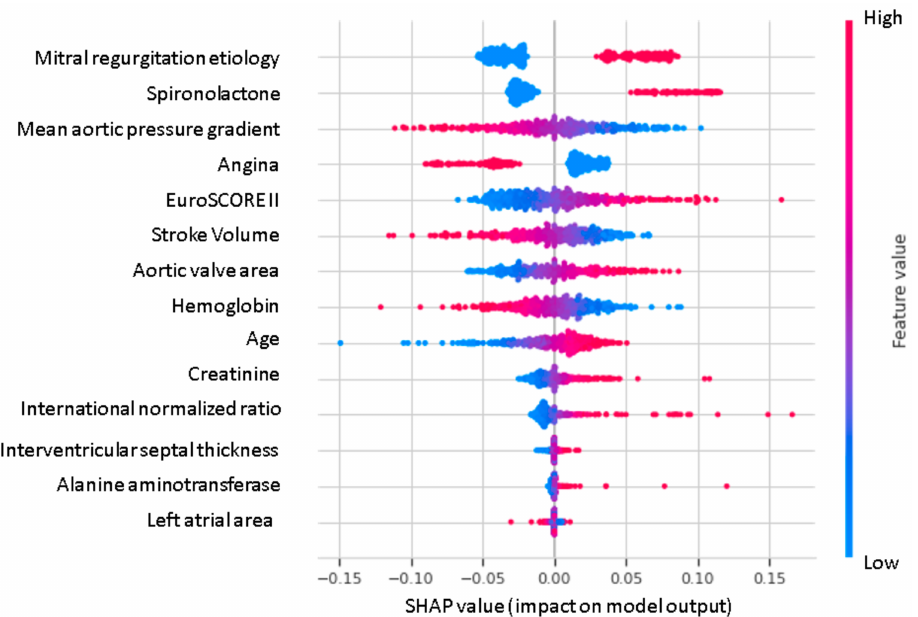
Figure 6. Shapley additive explanations value plot. The horizontal axis shows whether the effect of the feature is associated with a higher or lower prediction, while the color indicates whether the value of the feature is high (red) or low (blue) for a given